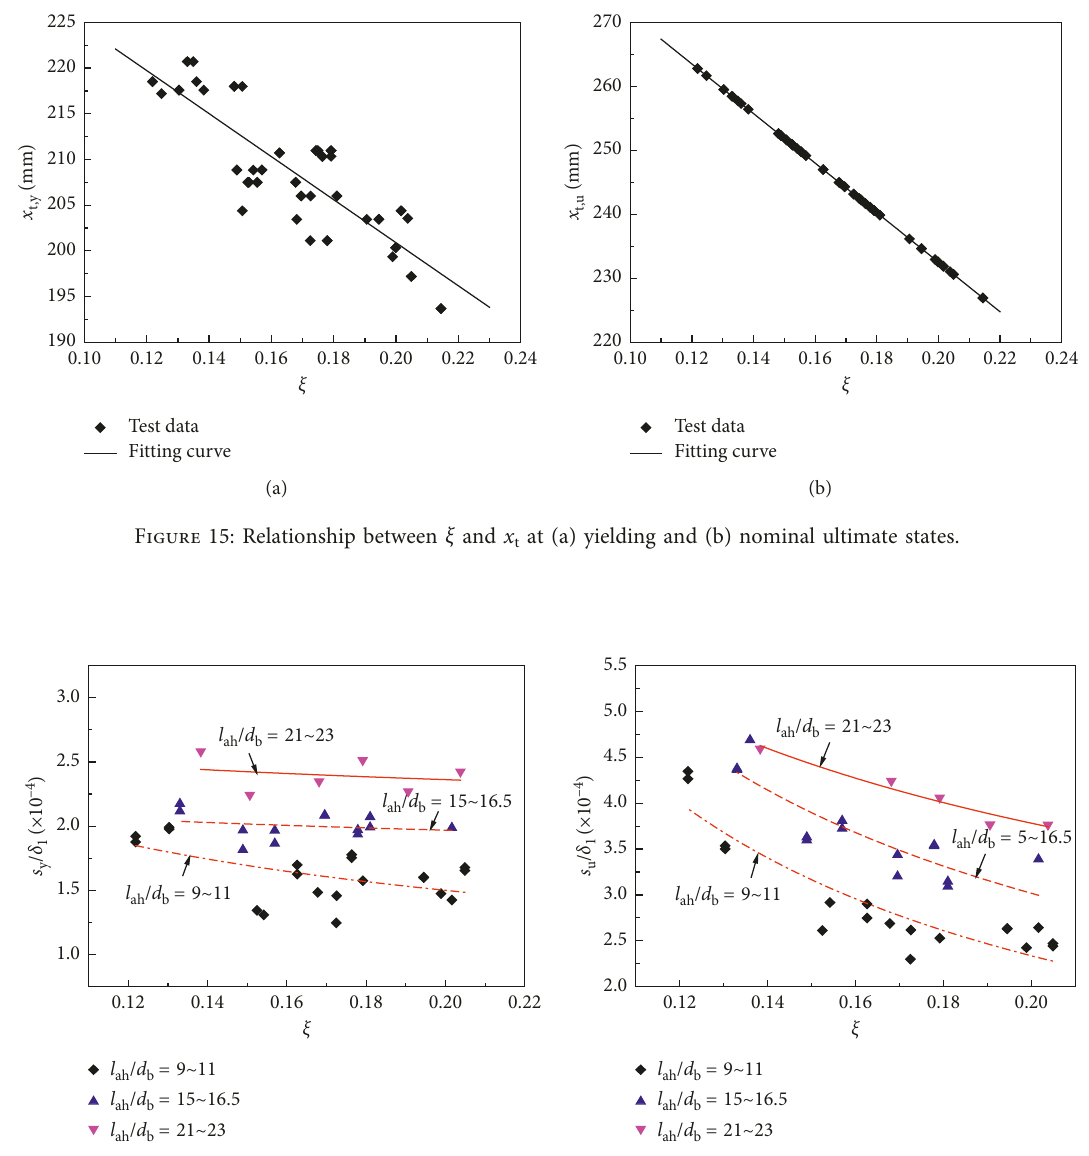
y / δ 1 and (b) s u / δ 1